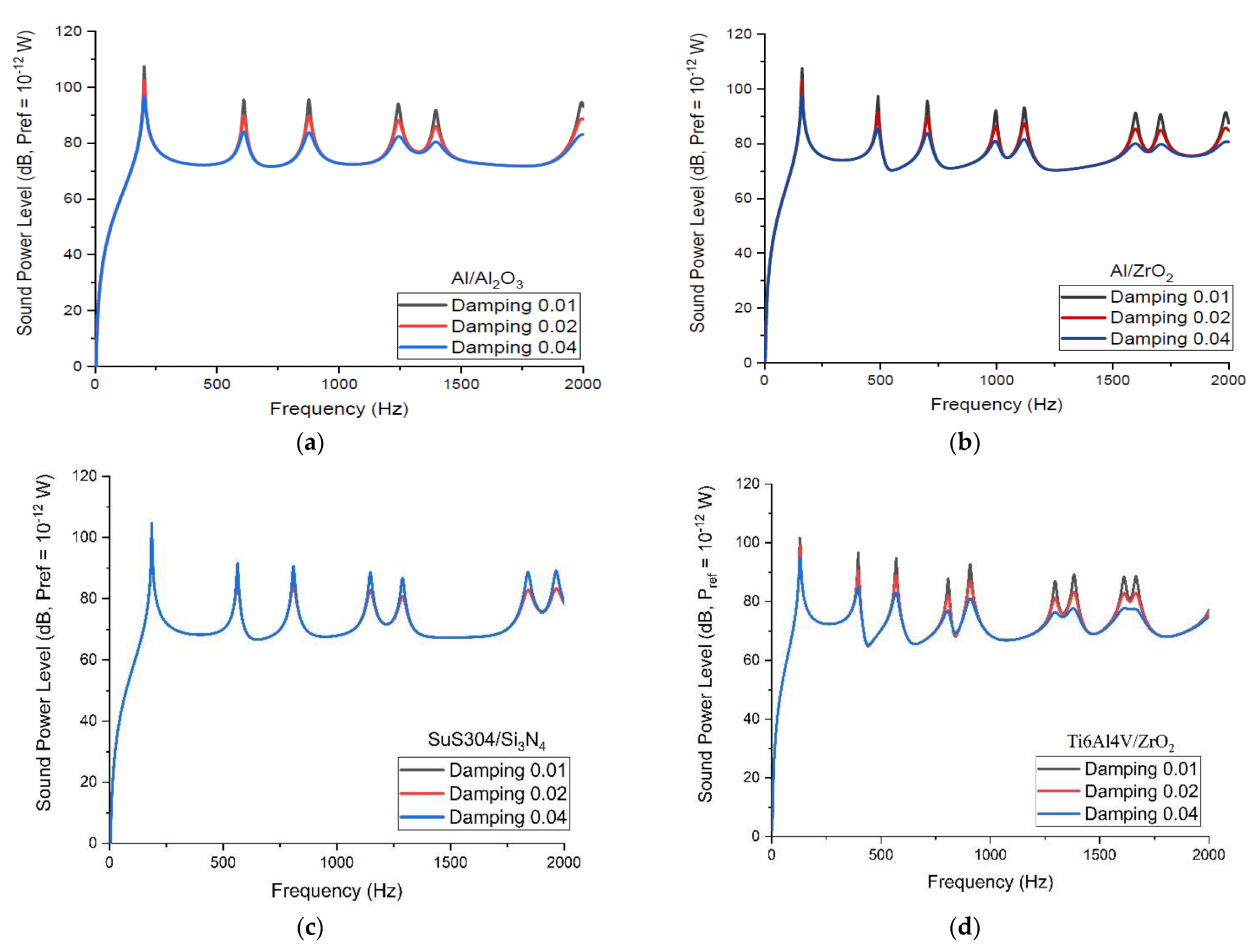
Figure 12. Sound power level for ( a ) Al/Al 2 O 3 , ( b ) Al/ZrO 2 , ( c ) SuS304/Si 3 N 4 , and ( d ) Ti6Al4V/ZrO 2 FGM plates under damping loss factor of 0.01, 0.02, and